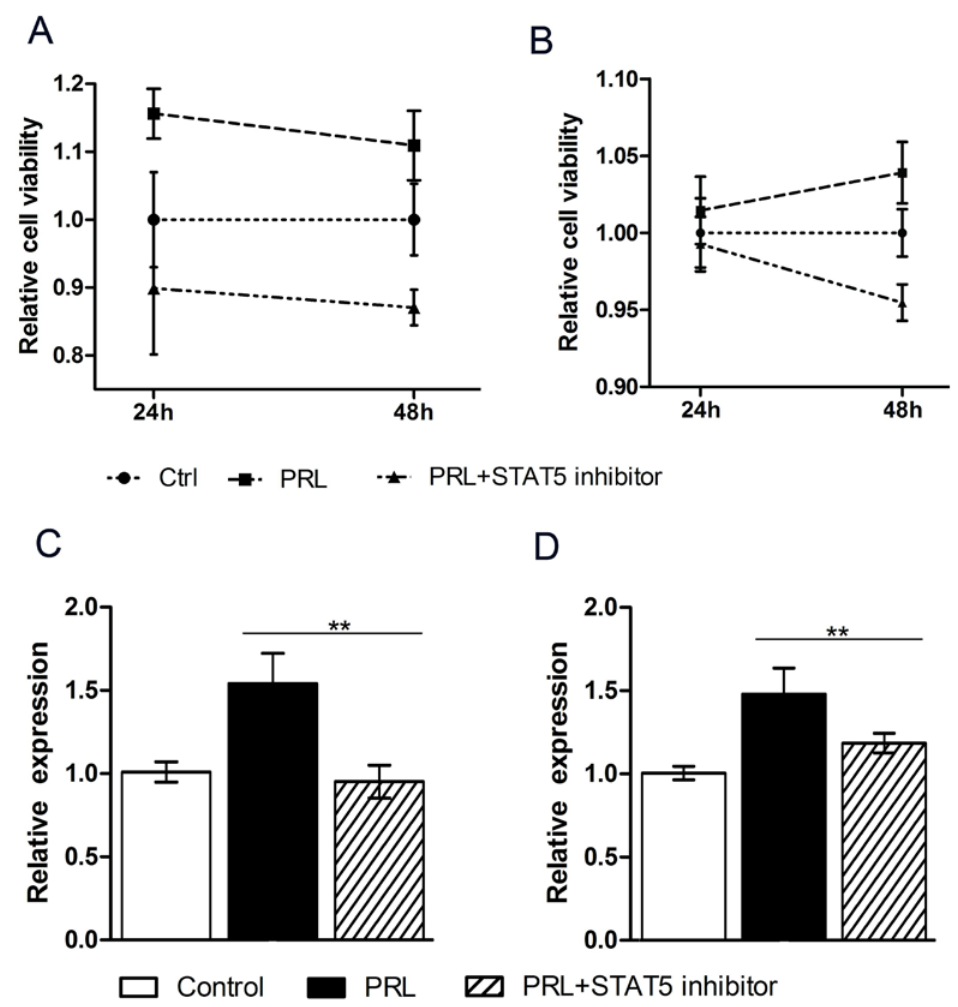
Figure 4. The STAT5 knockdown inhibits the expression of circHIPK3. ( A ) The relative cell viability of MAC-T cells; ( B ) The relative cell viability of HC11 cells; ( C ) The circHIPK3 expression in MAC-T inhibited by the STAT5 inhibitor; ( D ) The circHIPK3 expression in HC11 cells inhibited by the STAT5 inhibitor. Mean ± SEM of three samples from three independent experiments. * p < 0.05; ** p < 0.01.